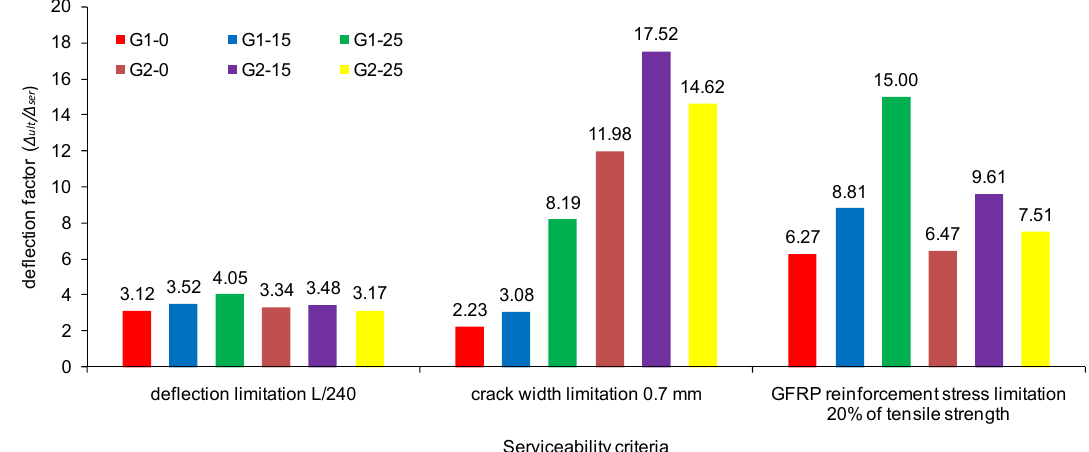
Figure 12. Strength factors for serviceability criteria limitations for the tested beams.